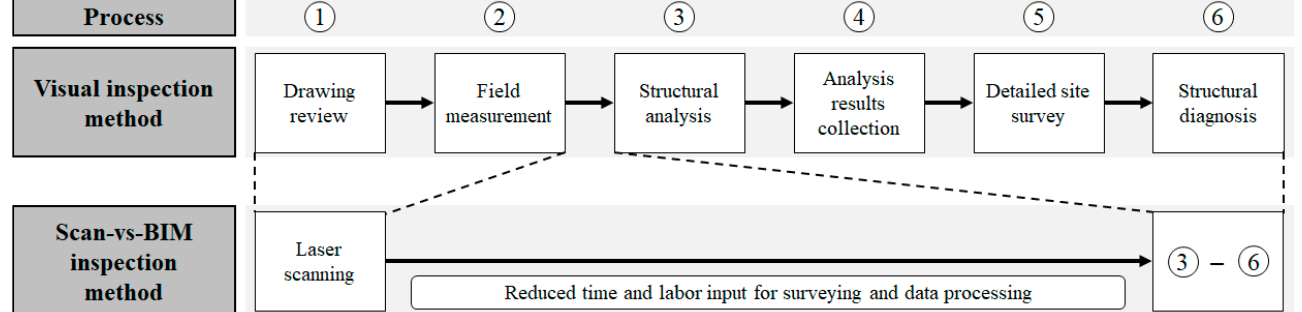
Figure 3. Comparison of traditional and Scan-vs-BIM processes.